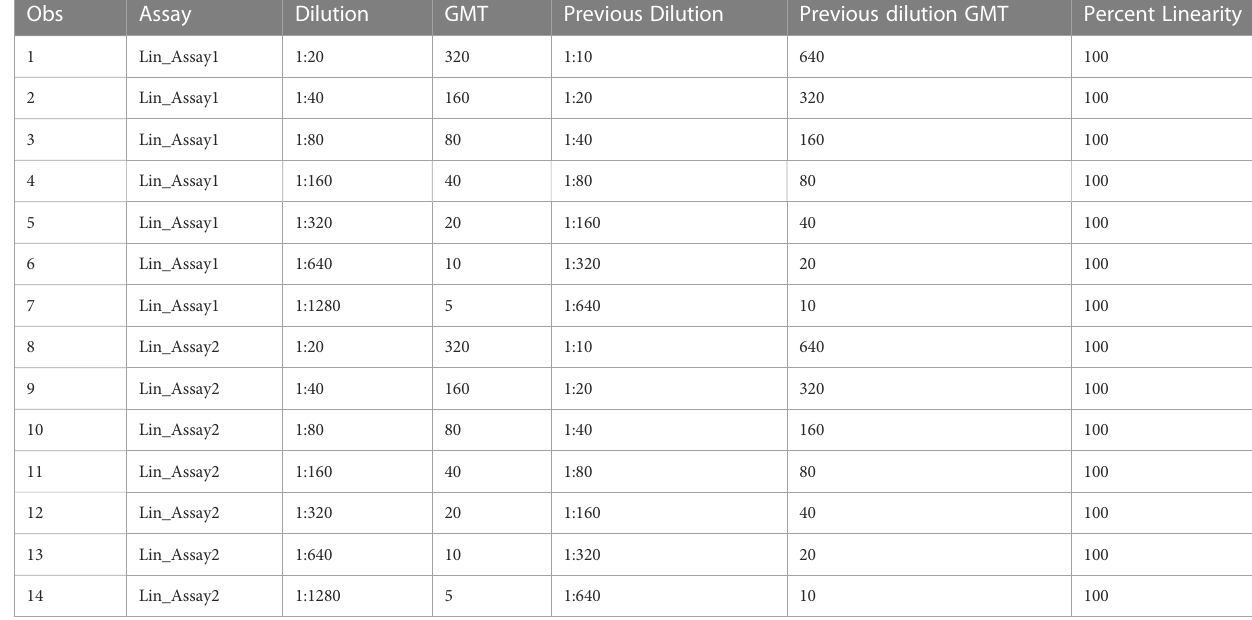
TABLE 5 HAI assay quali fi cation on H3N2 in fl uenza strain A/Texas/71/2017, linearity testing, percent linearity results. Obs Assay Dilution GMT Previous Dilution Previous dilution